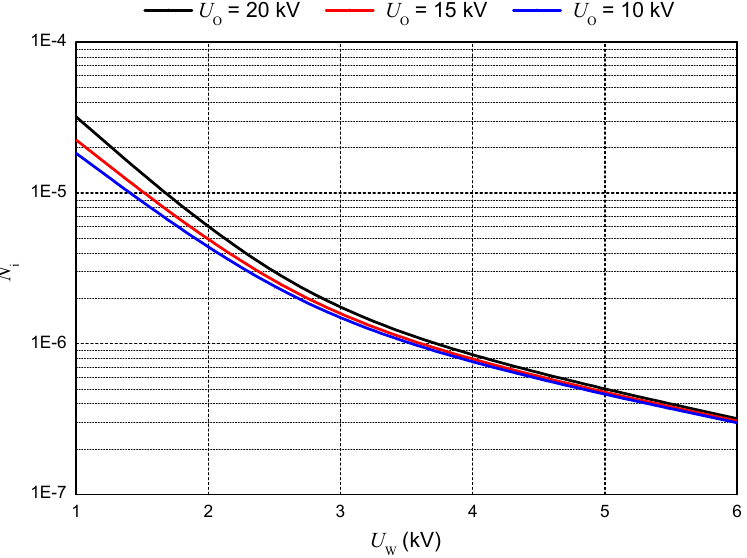
Figure 14. Frequency of damage N I to apparatus as a function of the withstand voltage U W of apparatus for LV circuits in multipolar cable.